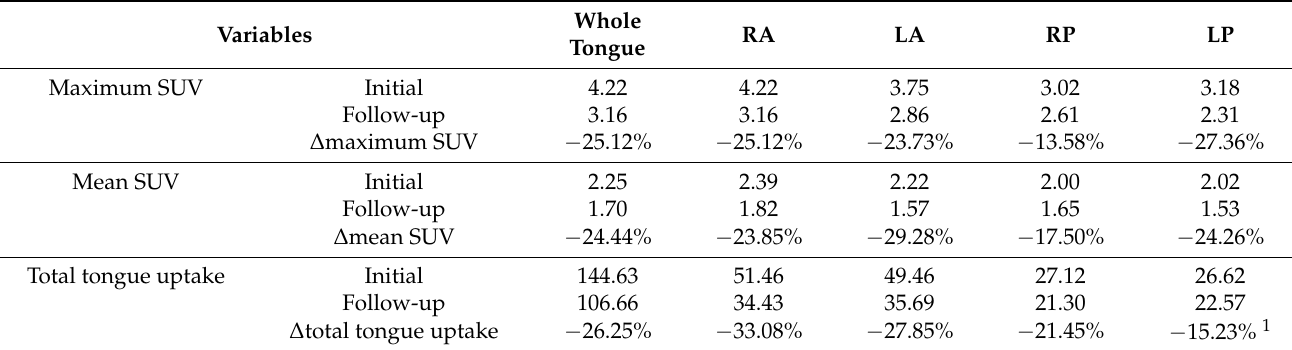
Table 1. Blood pool uptake and total tongue uptake on the initial and follow-up blood pool tongue single-photon emission tomography/computed tomography